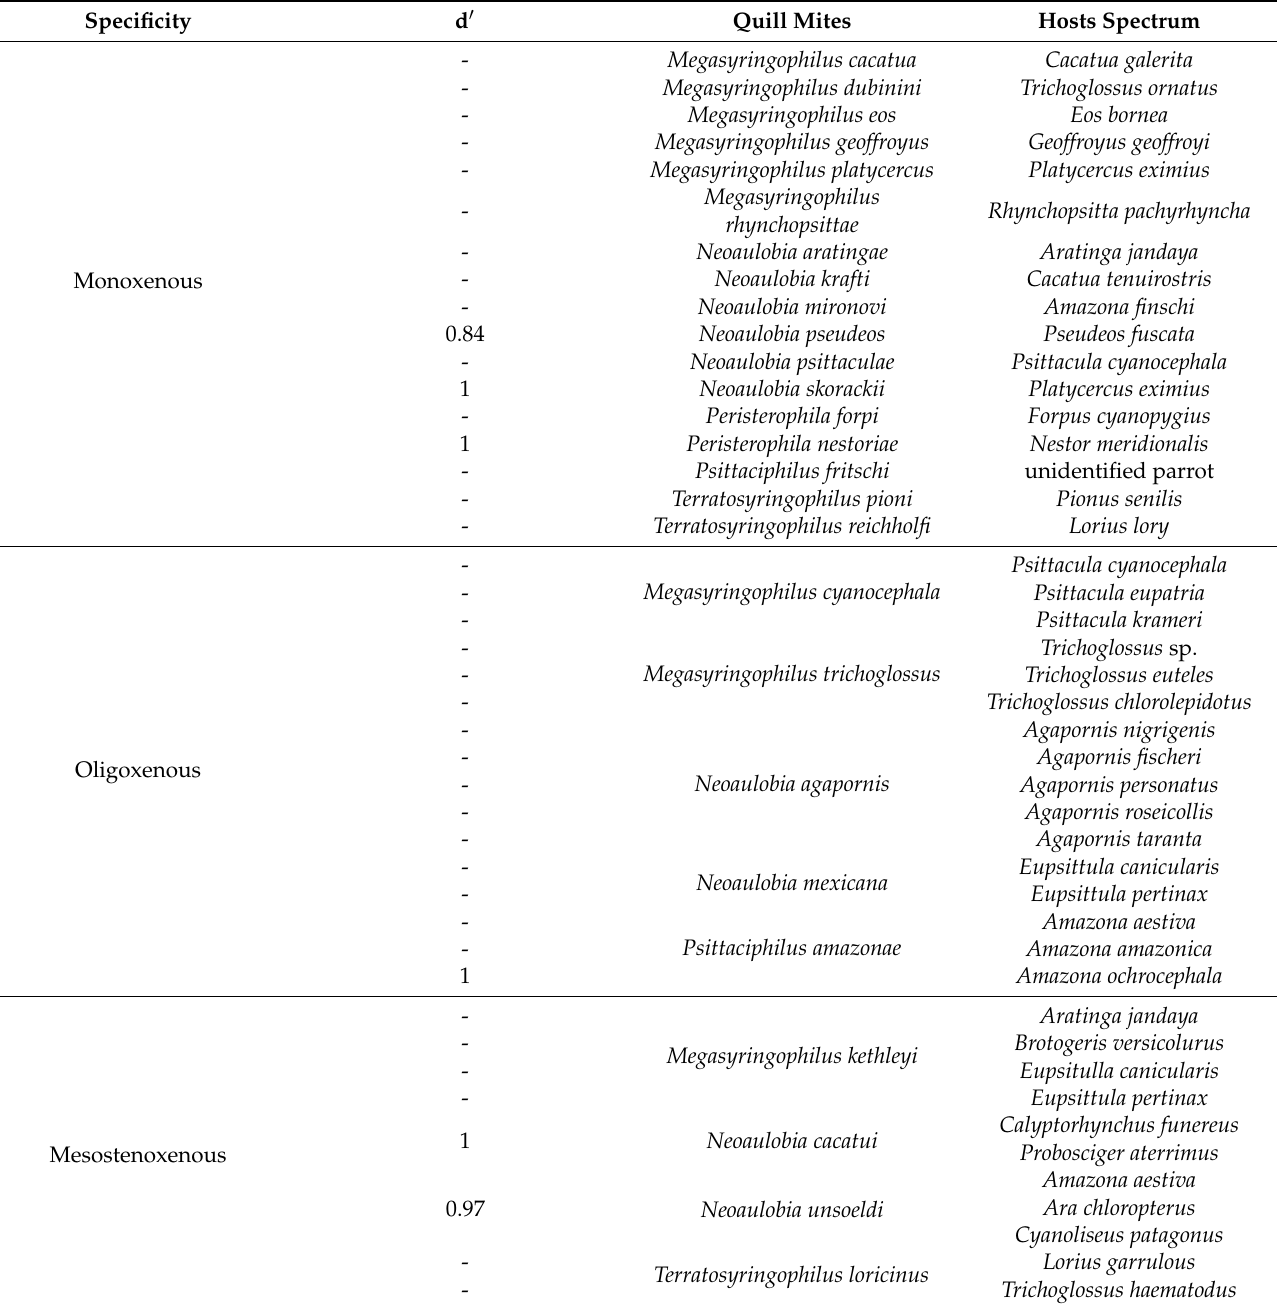
Table 3. Host specificity of quill mite species of the subfamily Syringophilinae with the value of d’